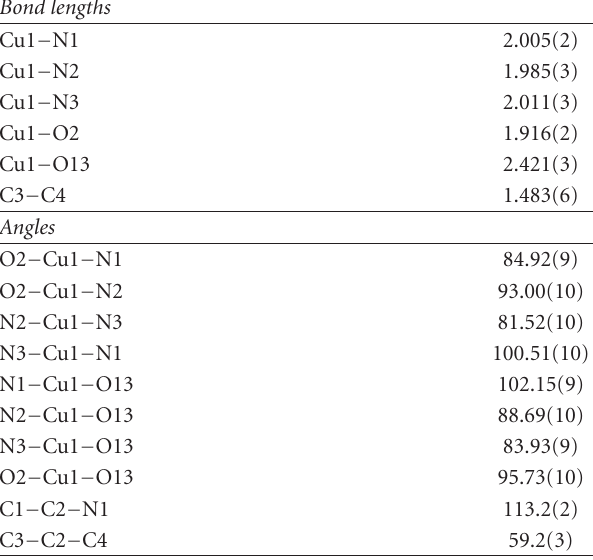
Table 2: Selected bond lengths (˚A) and angles ( ◦ ) for [(bpy)Cu(ACC)(H 2 O)]ClO 4 ( 1